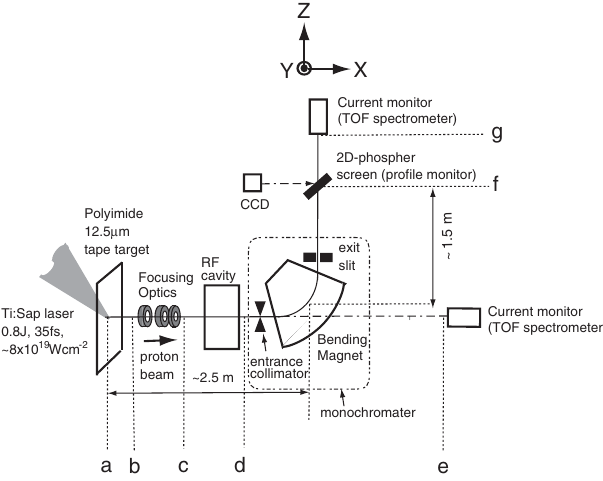
FIG. 1. Test transport line indicating planes referenced in the text. The axis z is always along the proton beam